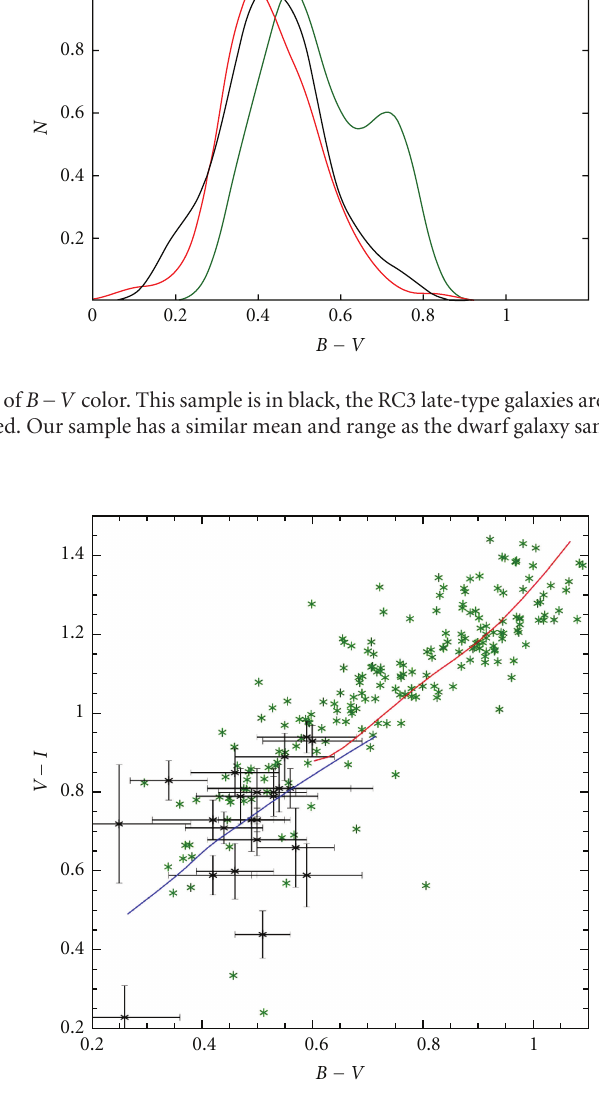
Figure 14: BVI color plane for the subsample of LSB galaxies with B − V and V − I colors (black symbols). RC3 galaxies are shown as green symbols. Also shown are 13 Gyrs stellar population tracks (instantaneous burst followed by passive evolution) for a range of metallicities (red) and a 1Gyr stellar population (blue). Given that the mean metallicity of LSB galaxies is about [Fe/H] = − 1.0 [16], there is no old stellar population that fits their B − V versus V − I colors. Therefore, all indicators are that there must be a significant younger population in LSB galaxies, despite their low stellar density